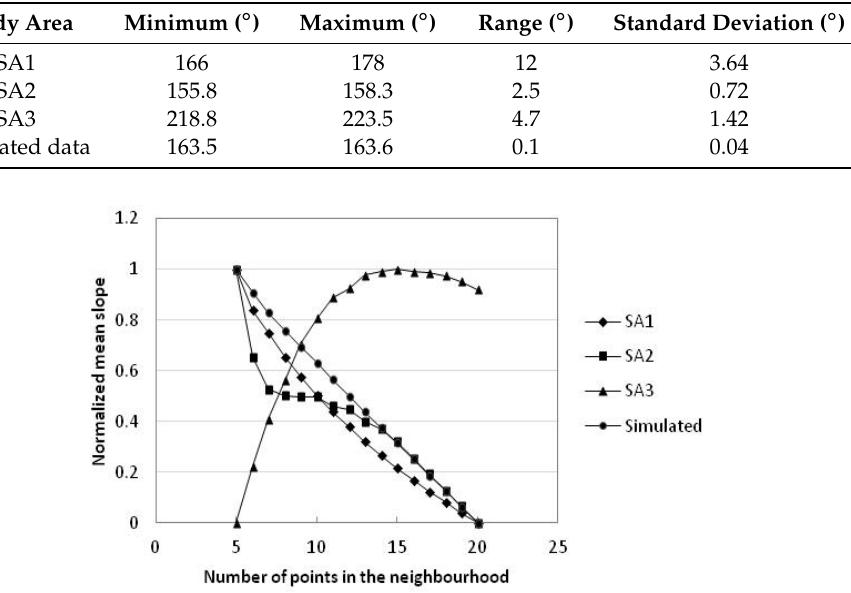
Figure 6. Plot of mean slope with number of points in the neighbourhood in study areas 1–3 and simulated data.